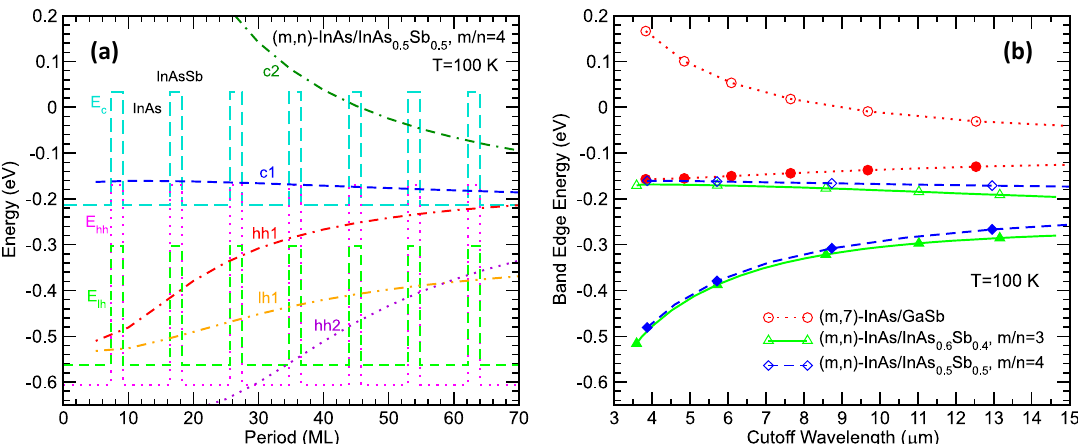
Figure 5. ( a ) The calculated c2, c1, hh1, lh1, and hh2 energy levels for a set of (4 n , n )-InAs/InAs 0.5 Sb 0.5 superlattices, plotted as functions of superlattice period in monolayers (MLs). The background shows a relevant superlattice energy band diagram, with an arbitrary horizontal length scale. ( b ) The calculated superlattice conduction band edge ( E c1 , open symbols) and valence band edge ( E hh1 , solid symbols) as functions of the cutoff wavelength for sets of ( m ,7)-InAs/GaSb, (3 n , n )-InAs/InAs 0.6 Sb 0.4 and (4 n , n )-InAs/InAs 0.5 Sb 0.5 superlattices.